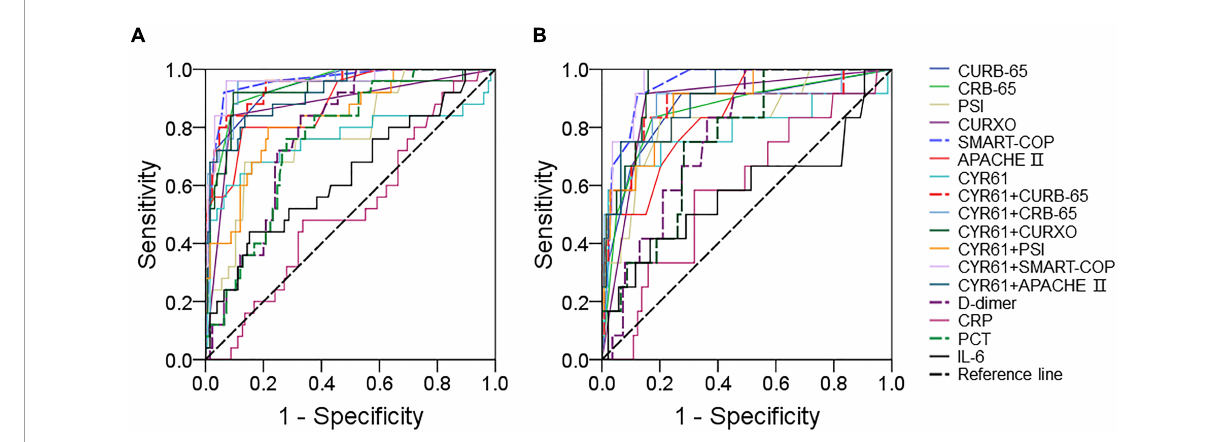
FIGURE3 The predictive capacities of different biomarkers for severity and death. (A,B) The predictive powers for severity and death were evaluated through ROC curve in many biomarkers. (A) The predictive power for severity was analyzed through ROC curve among CAP severity scores, serum CYR61, markers of inflammation, and infection. (B) The predictive power for death was estimated via ROC curve among CAP severity scores, serum CYR61, markers of inflammation, and